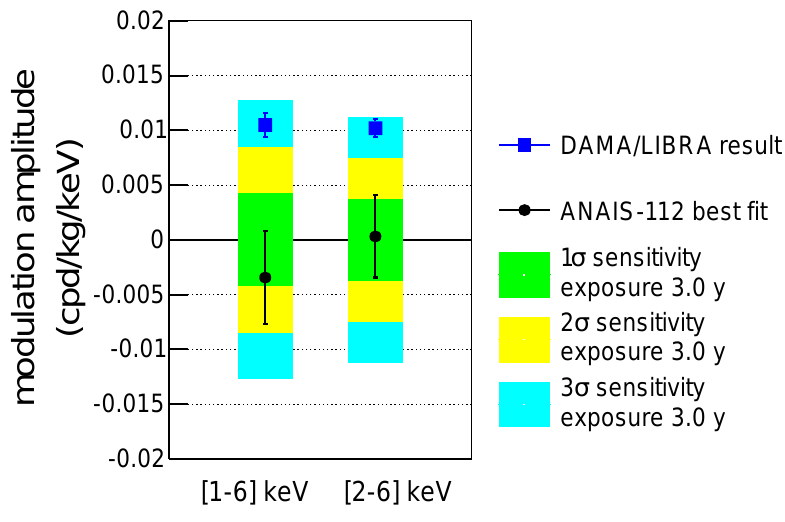
Figure 29: The ANAIS best-fit modulation amplitude result compared with the DAMA / LIBRA best-fit result for both recoil energy ranges considered by DAMA / LIBRA. Figure from Ref. [ 41 ]